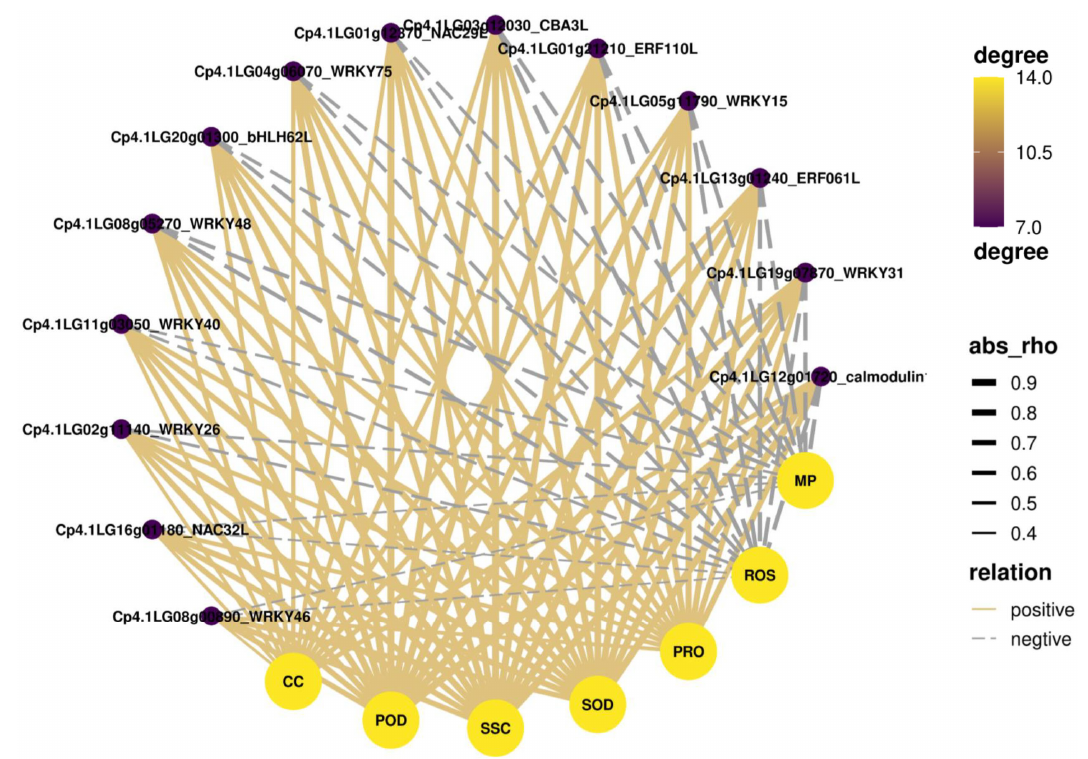
Figure 4. Correlation analysis between the 14 common differentially expressed TFs in FA/LT, CHA/LT, and BHA/LT comparisons and the physiological indexes. CC, chlorophyll content. POD, peroxidase. SSC, soluble sugar contents. SOD, superoxide dismutase. PRO, proline. ROS, reactive oxygen species. MP, plasma membrane permeability.